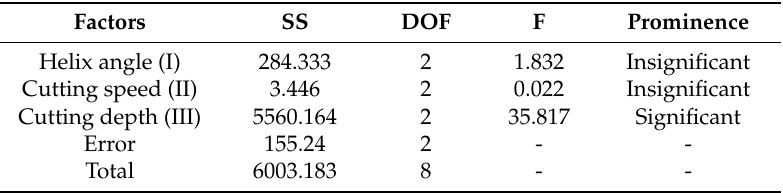
Table 5. ANOVA of cutting force with R ‐ squared of 0.94.